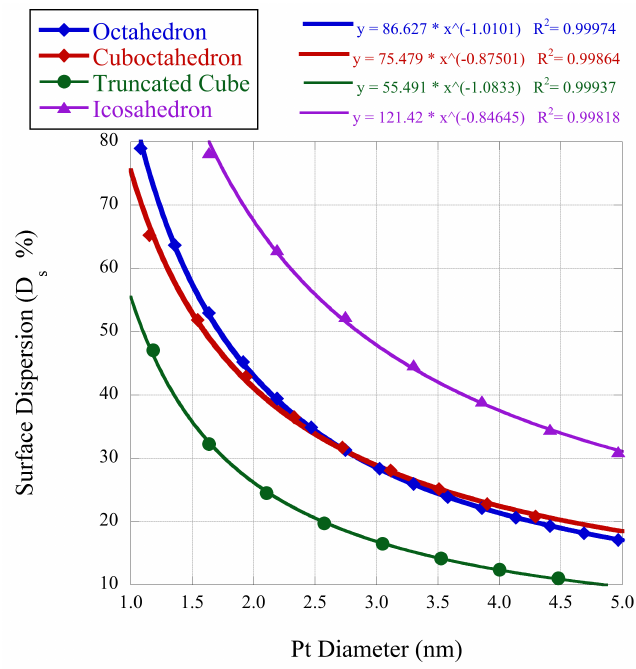
Figure 4. Surface dispersion for the four platinum shapes under